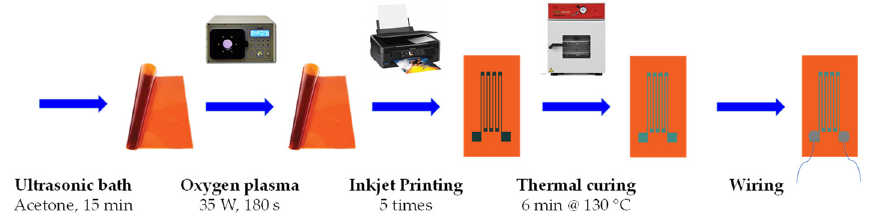
Figure 3. Fabrication process by inkjet printing for poly(3,4-ethylenedioxythiophene):poly(styrene sulfonate) (PEDOT:PSS) -based strain gauge.